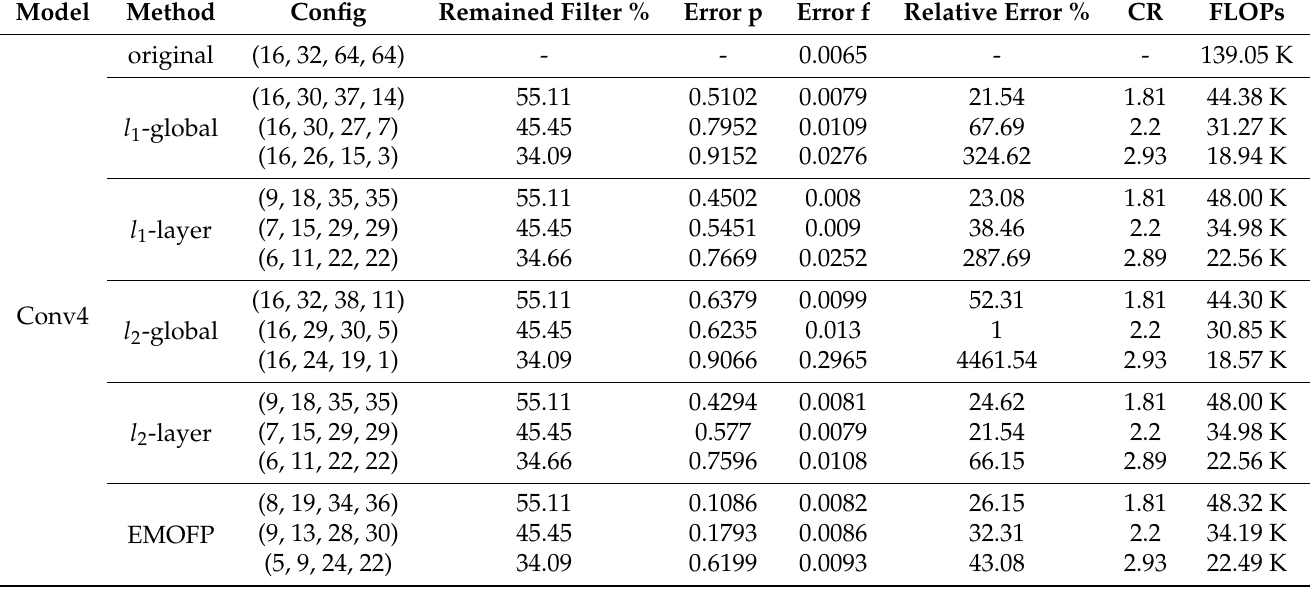
Table 6. Pruning results of Conv4 on